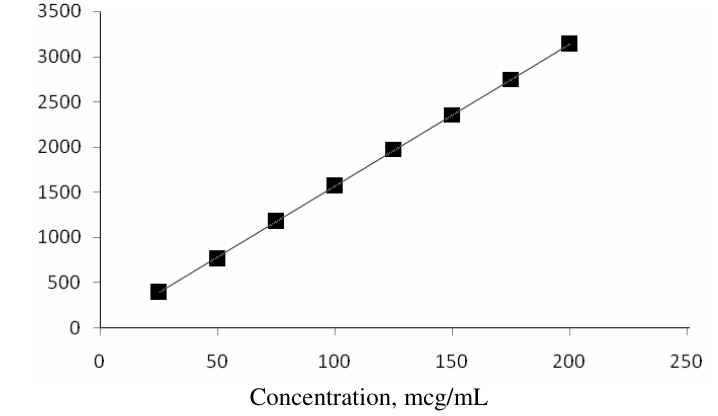
Figure 1. Calibration curve of nevirapine by RP- HPLC Table 1 . Calibration curve points of the proposed